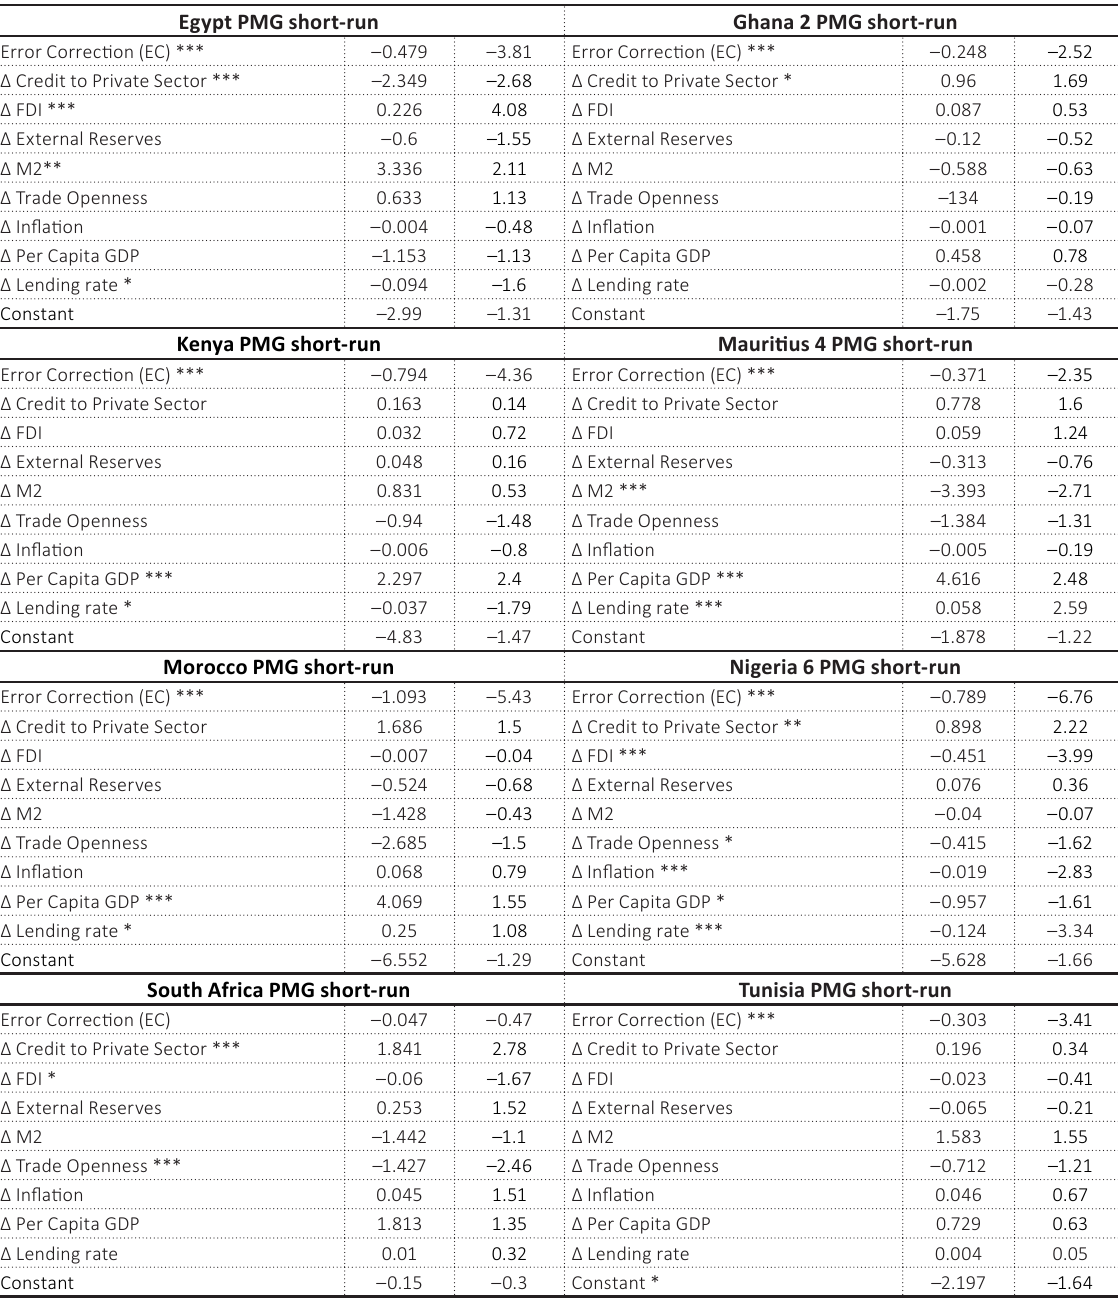
Table 2. Country-specific pooled mean group estimator short-run result Egypt PMG short-run Ghana 2 PMG